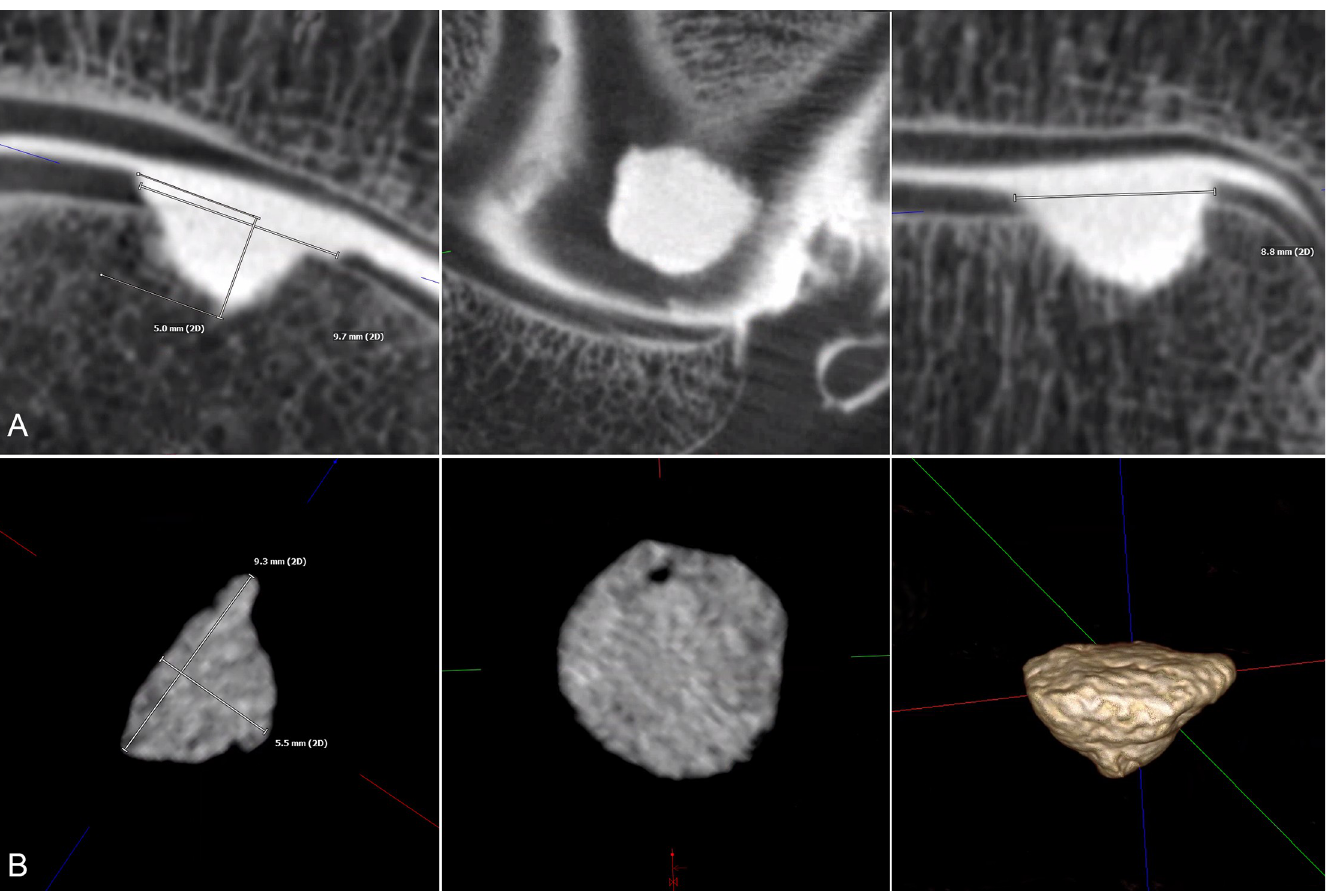
Fig 1. Osteochondral defect measurement. Example of measurements in flat panel computed tomography arthrography (FPCT-A) with a multiplane reconstruction of the same defect in three planes (A) and the corresponding cast specimen (B) in two planes and a 3D rendering mode.